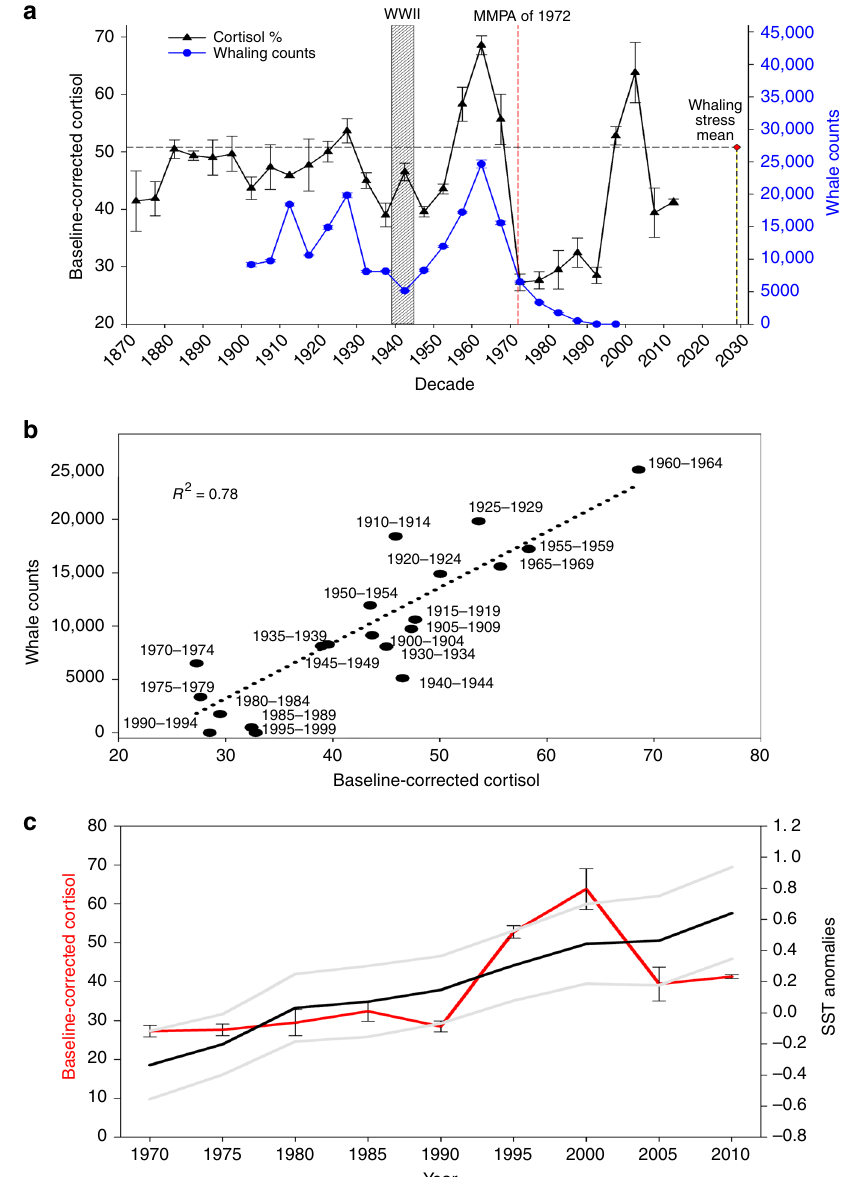
Fig. 3 Whale cortisol relationship with whaling numbers and sea-surface temperature. a Mean baseline-corrected cortisol (± SE) with corresponding whaling counts (± SE) of the 20th century for blue, fi n, and humpback whales in the Northern Hemisphere. Striped bar corresponds to World War II years (1939 – 1945). For reference, the red dashed line connotes the Marine Mammal Protection Act of 1972. N = 1084 lamina; 1870s, n = 17; 1880s, n = 20; 1890s, n = 20; 1900s, n = 35; 1910s, n = 32; 1920s, n = 71; 1930s, n = 144; 1940s, n = 225; 1950s, n = 212; 1960s, n = 89; 1970s, n = 60; 1980s, n = 60; 1990s, n = 60; 2000s, n = 27; 2010s, n = 12). Whaling counts (total deaths) and ±SE calculated from Rocha et al. 26 . b Relationship between 5-year mean baseline-corrected cortisol (± SE) and 5-year mean whaling counts (± SE) for the 20th century ( r 2 value = 0.78). c 1970 – 2016 baseline-corrected cortisol (± SE; red line) and SST anomalies (1971 – 2000 35 ; black line with 95% con fi dence interval as gray; r 2 value = 0.46). SE standard error of the